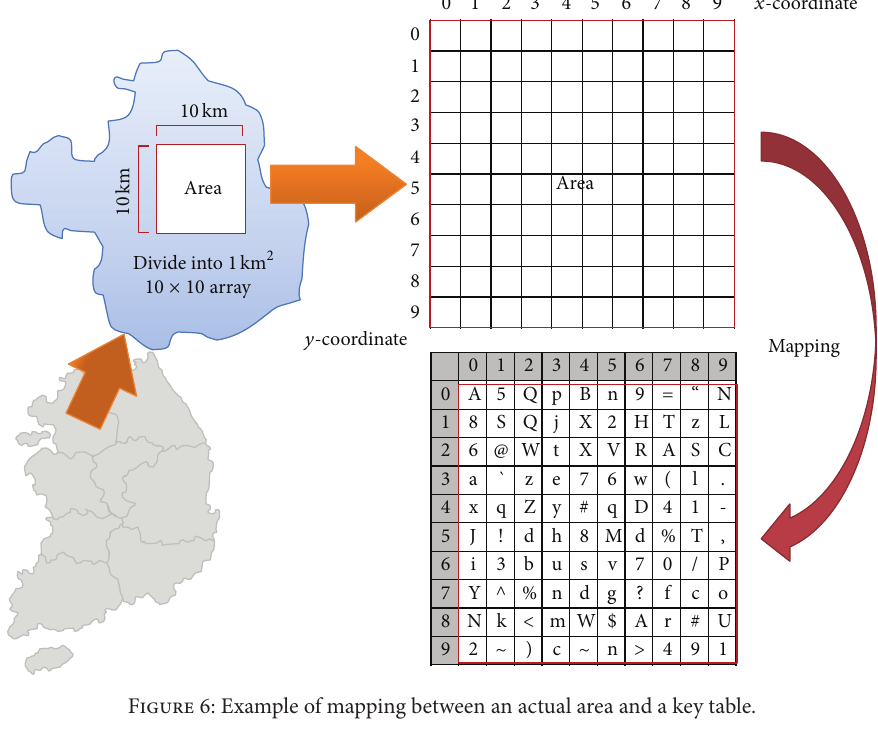
Figure 6: Example of mapping between an actual area and a key table.